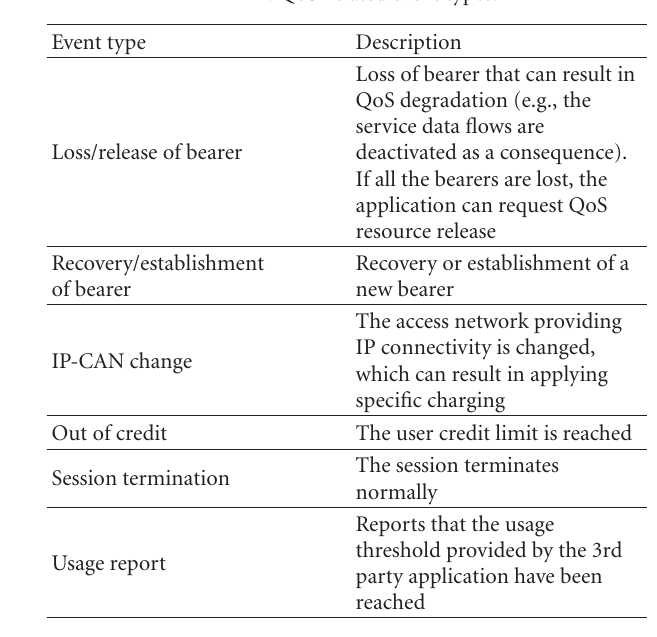
Table 1: QoS-related event